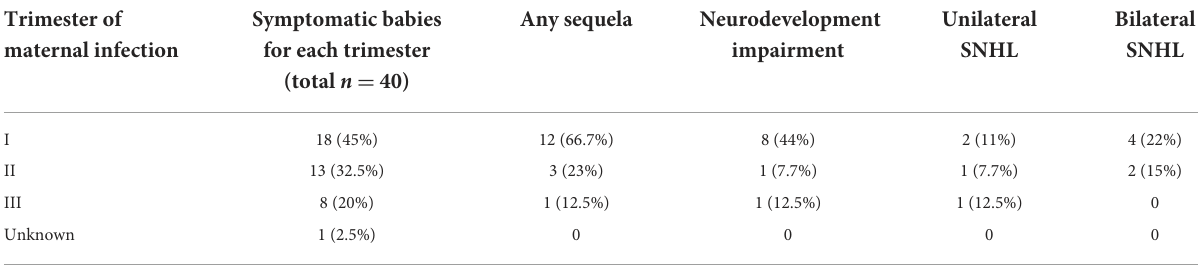
TABLE 3 Outcome of symptomatic children born to mothers with primary infection divided according to trimester of infection. Trimester of maternal